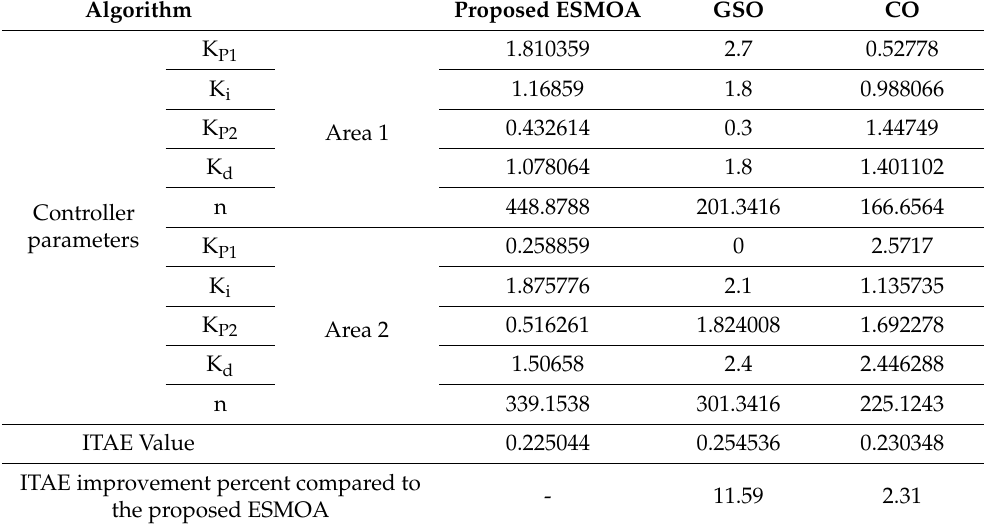
Figure 15. Convergence characteristics for CO, GSO, and the proposed ESMOA for Case 4.